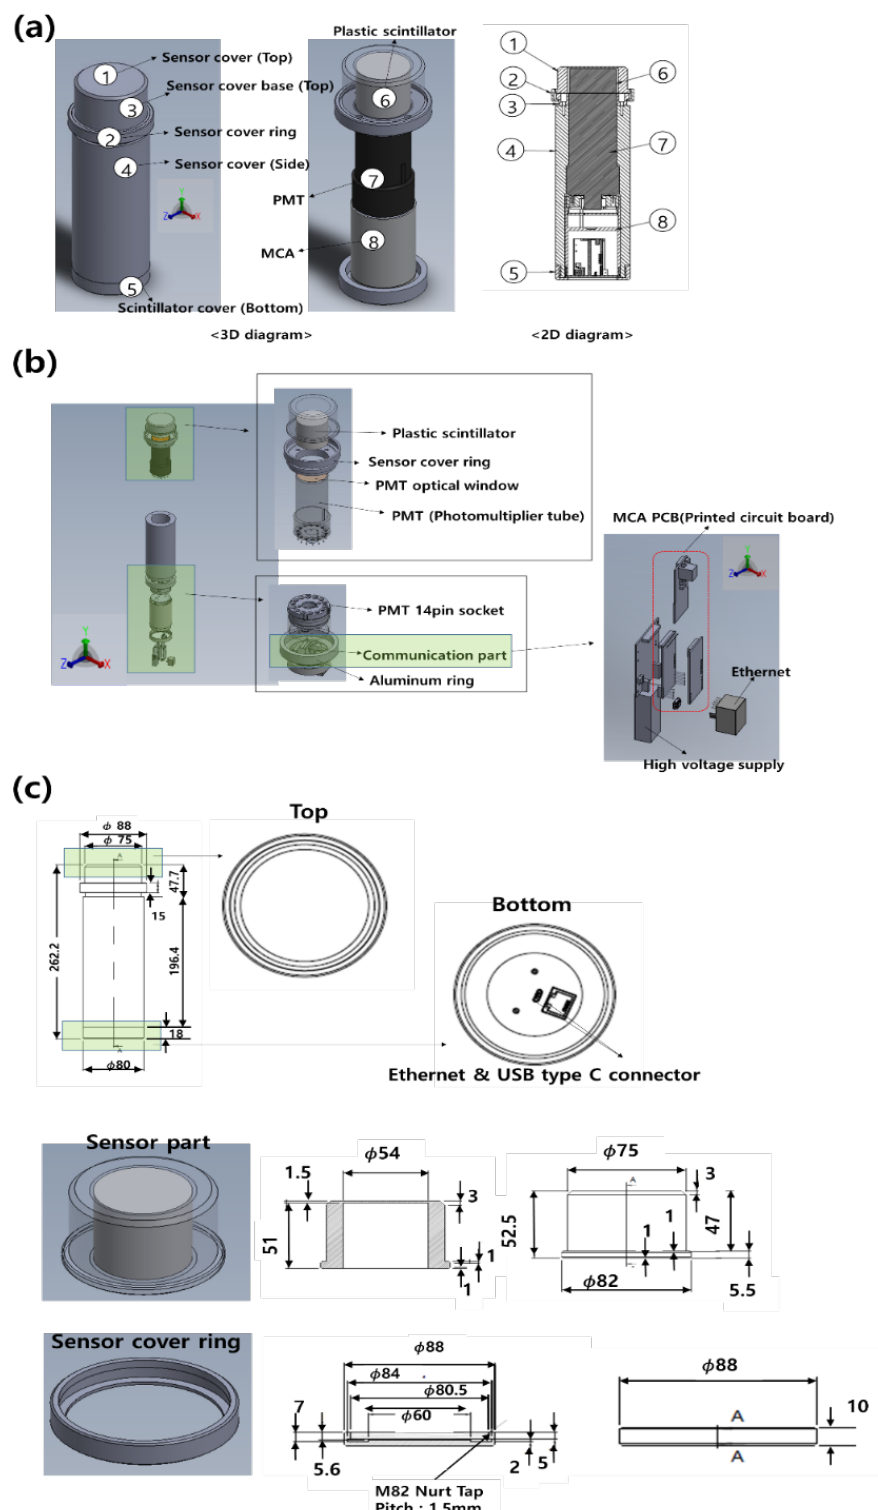
Figure 5. Schematic illustration of the plastic detector system. ( a ) Drawing of the plastic detector. ( b ) Detailed drawing of the detection part and signal-processing part. ( c ) Plastic detector size in detailed drawing.